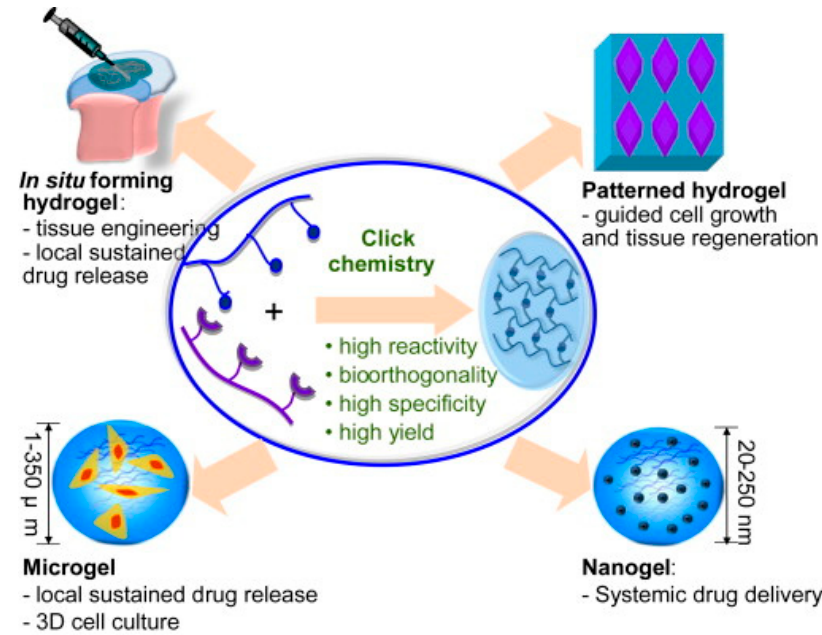
Figure 4. Schematic representation of click hydrogels, microgels, and nanogels synthesis and their potential biomedical applications. Reproduced with permission from [122]. Copyright Elsevier, 2014.